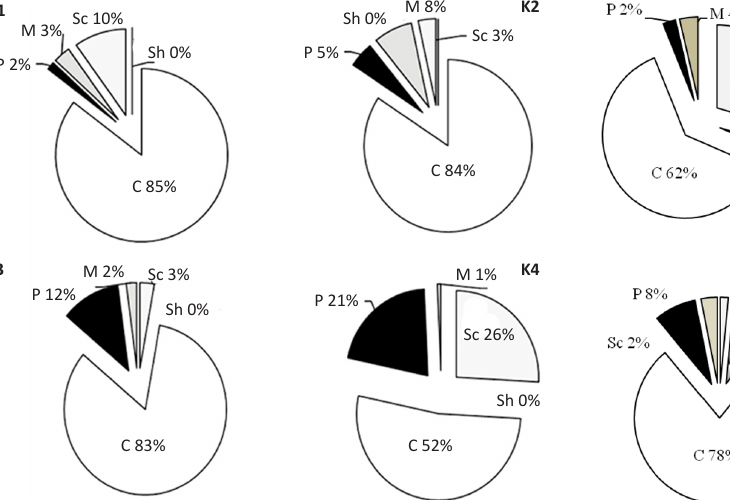
Figure 2. Percentage composition of functional feeding groups at various stations in the Ken River. C - Collector; M - Miscellaneous; P - Predator; Sh - Shredder; Sc - Scraper